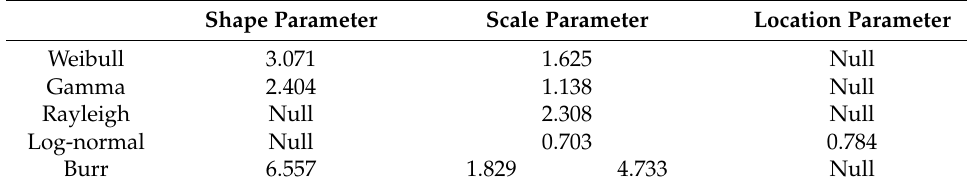
Table 1. Parameter estimation of wind speed distribution. Shape Parameter